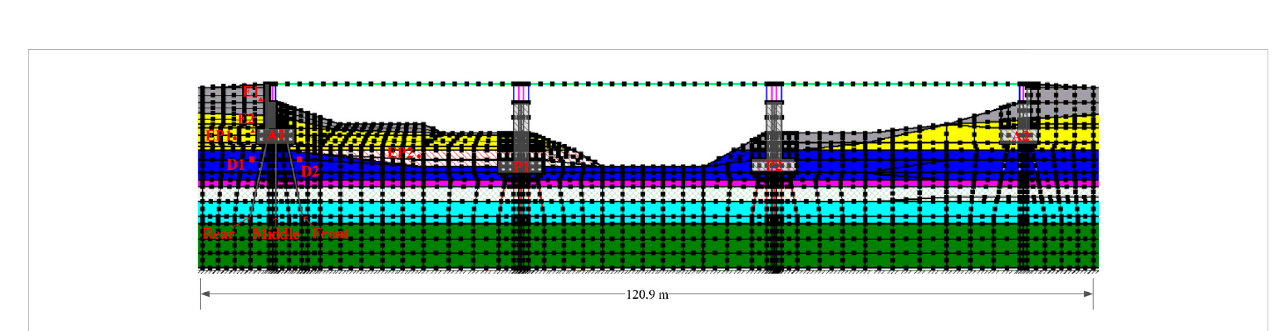
FIGURE 2 Finite element model for the soil – pile — bridge system.